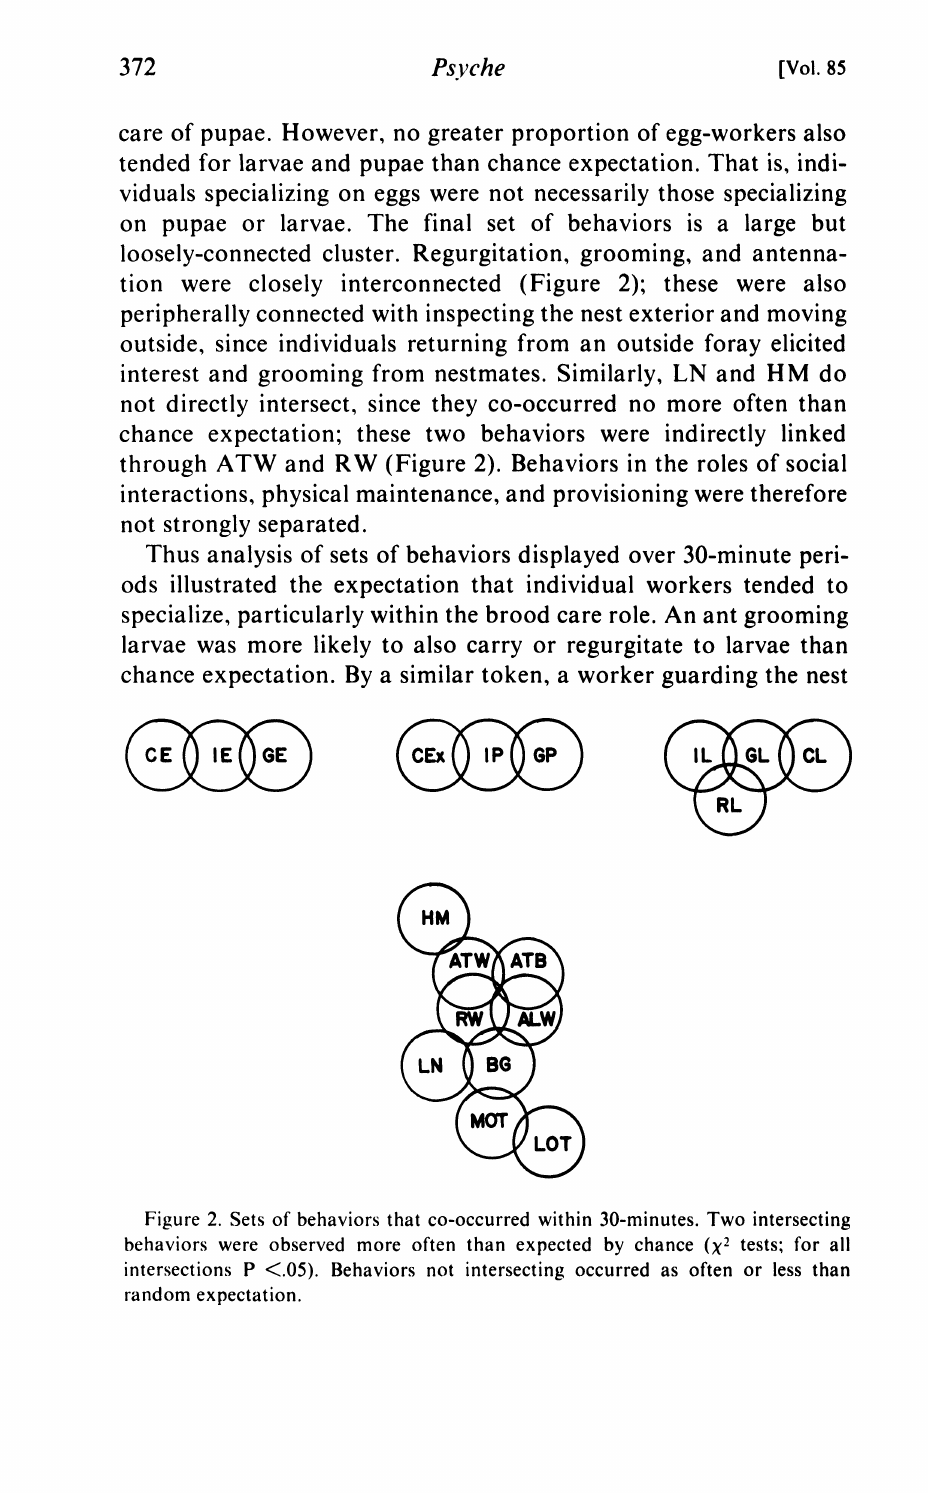
Figure 2. Sets of behaviors that co-occurred within 30-minutes. Two intersecting behaviors were observed more often than expected by chance (X" tests; for all intersections P <.05). Behaviors not intersecting occurred as often or less than random